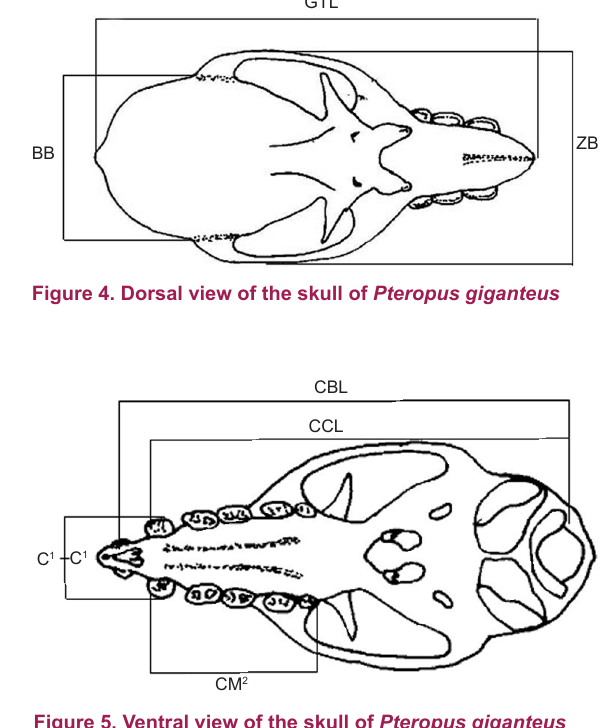
Figure 5. Ventral view of the skull of Pteropus giganteus